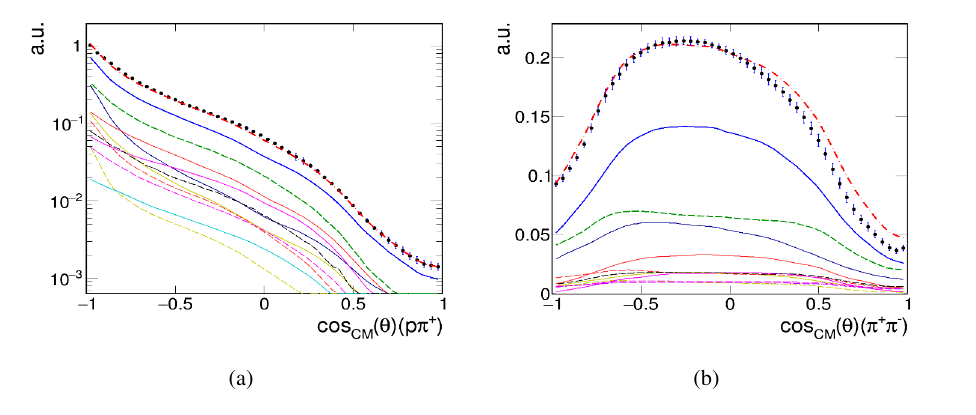
Figure 2: Distribution of center-of-mass angles of the p π + (a) and π + π − (b) pairs in HADES acceptance, compared to simulations (color code same as Figure